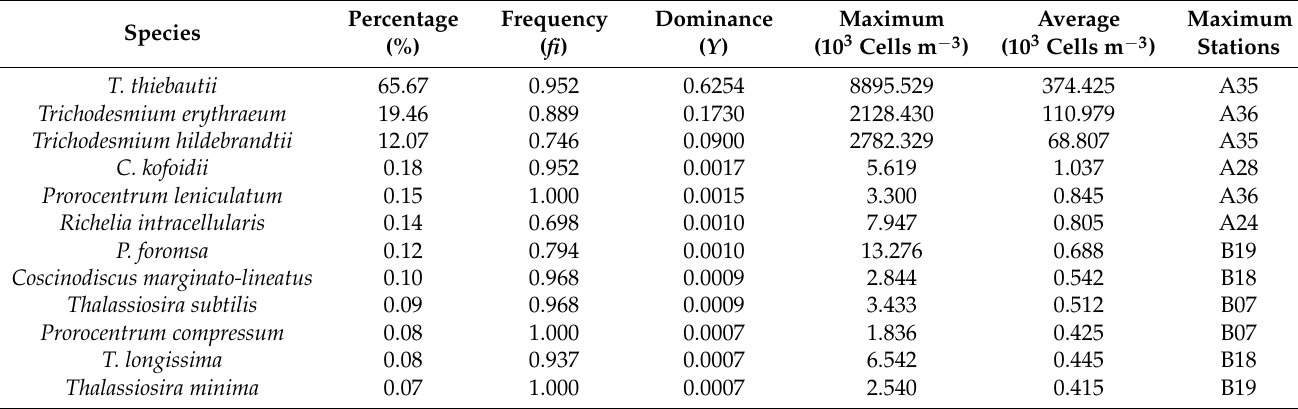
Table 2. Dominant phytoplankton species in the